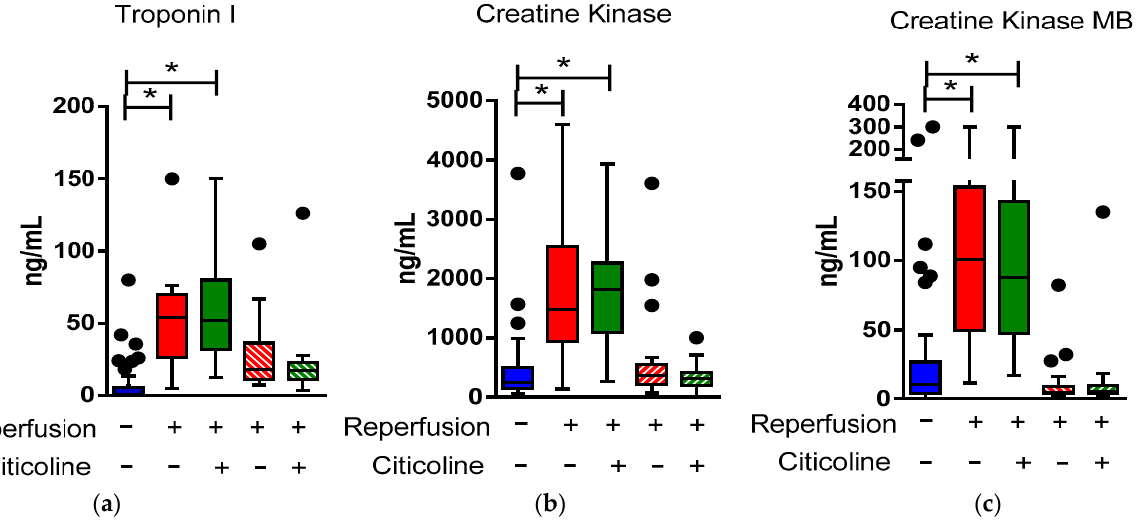
Figure 1. Box and whisker plot (Tukey Method, outliers in black dots) illustrates the total distribution of enzymatic necrosis markers before (AMI) and after primary angioplasty with and without citicoline: ( a ) Troponin-I, ( b ) creatine kinase, and ( c ) creatine kinase MB values before and after primary angioplasty at 24 h (solid colors) and at 72 h (dashed colors) in patients with ST-myocardial infarction (STEMI), n = 56, who received placebo ( n = 28) or citicoline ( n = 28). p value was determined using one-way ANOVA. * p <